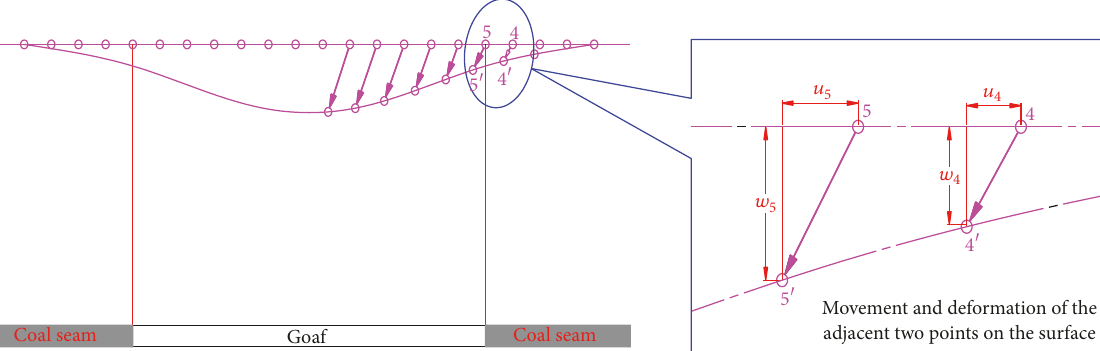
Figure 3: Movement of surface points after shallow coal seam